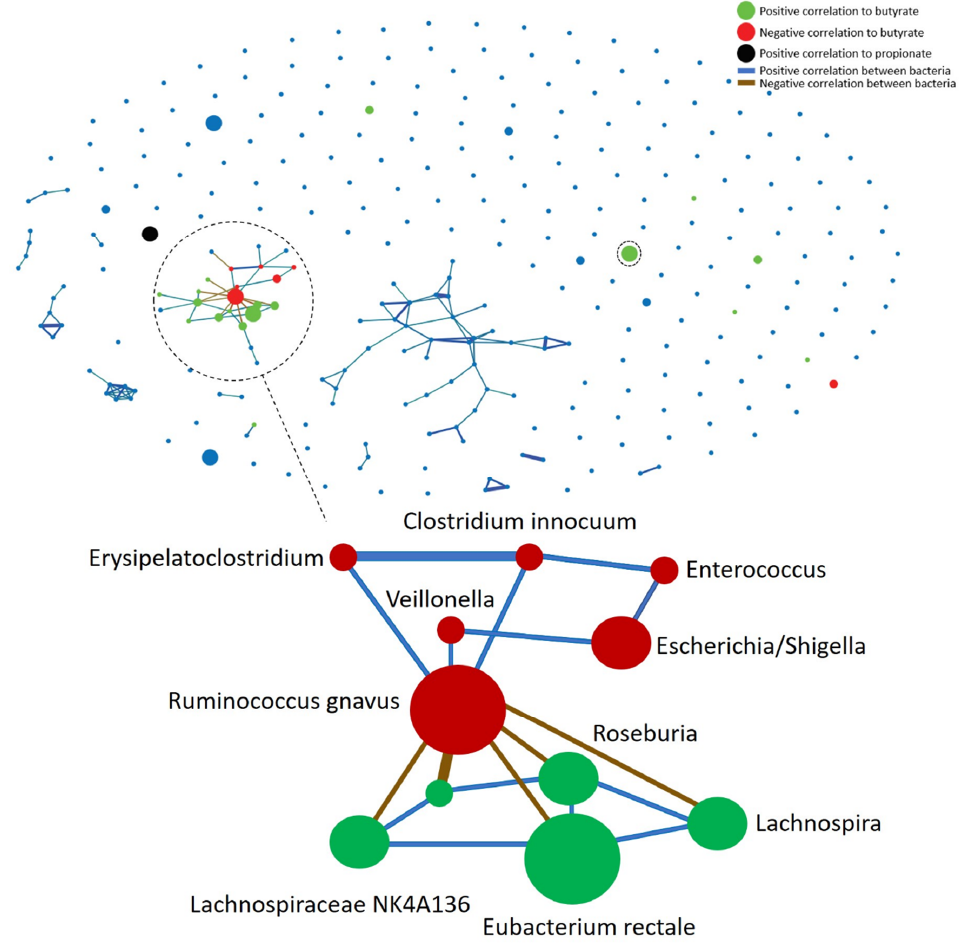
Figure 5. Bacterial and SCFA correlations at 12 months. The illustration shows all OTUs from 16S rRNA represented as nodes, with color indicating their correlation to SCFAs; blue = no correlation, red = negative correlation to butyrate, green = positive correlation to butyrate, and black = positive correlation to propionate. The three di ff erent node sizes represent the general abundance of the respective bacteria. The thickness of the lines between nodes represents a correlation between the bacteria, of which a thick line is a strong correlation. Blue lines indicate a positive correlation between the bacteria, while brown lines indicate a negative correlation. Prominent nodes in the networks are highlighted with their respective OTU taxonomy. The highlighted green circle with positive association to butyrate but without correlations to other bacteria was assigned to Faecalibacterium .